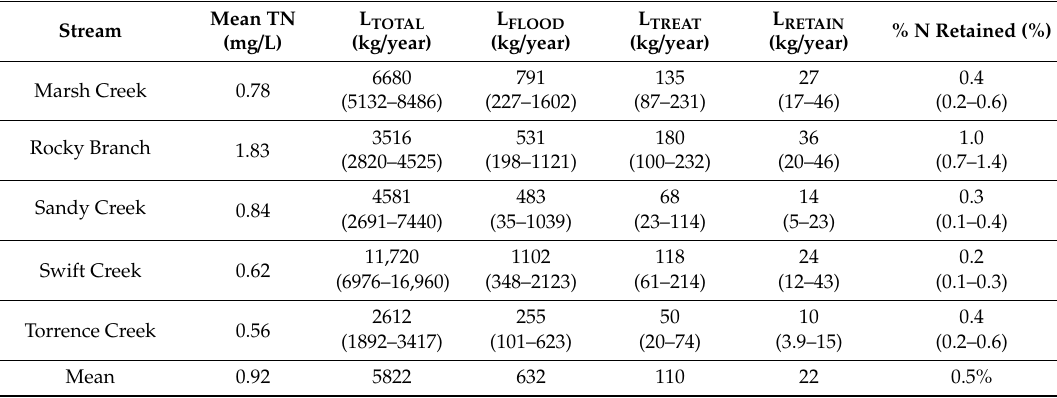
Table 4. Summary of average annual floodplain nitrogen retention by site. Bracketed numbers are the range in annual